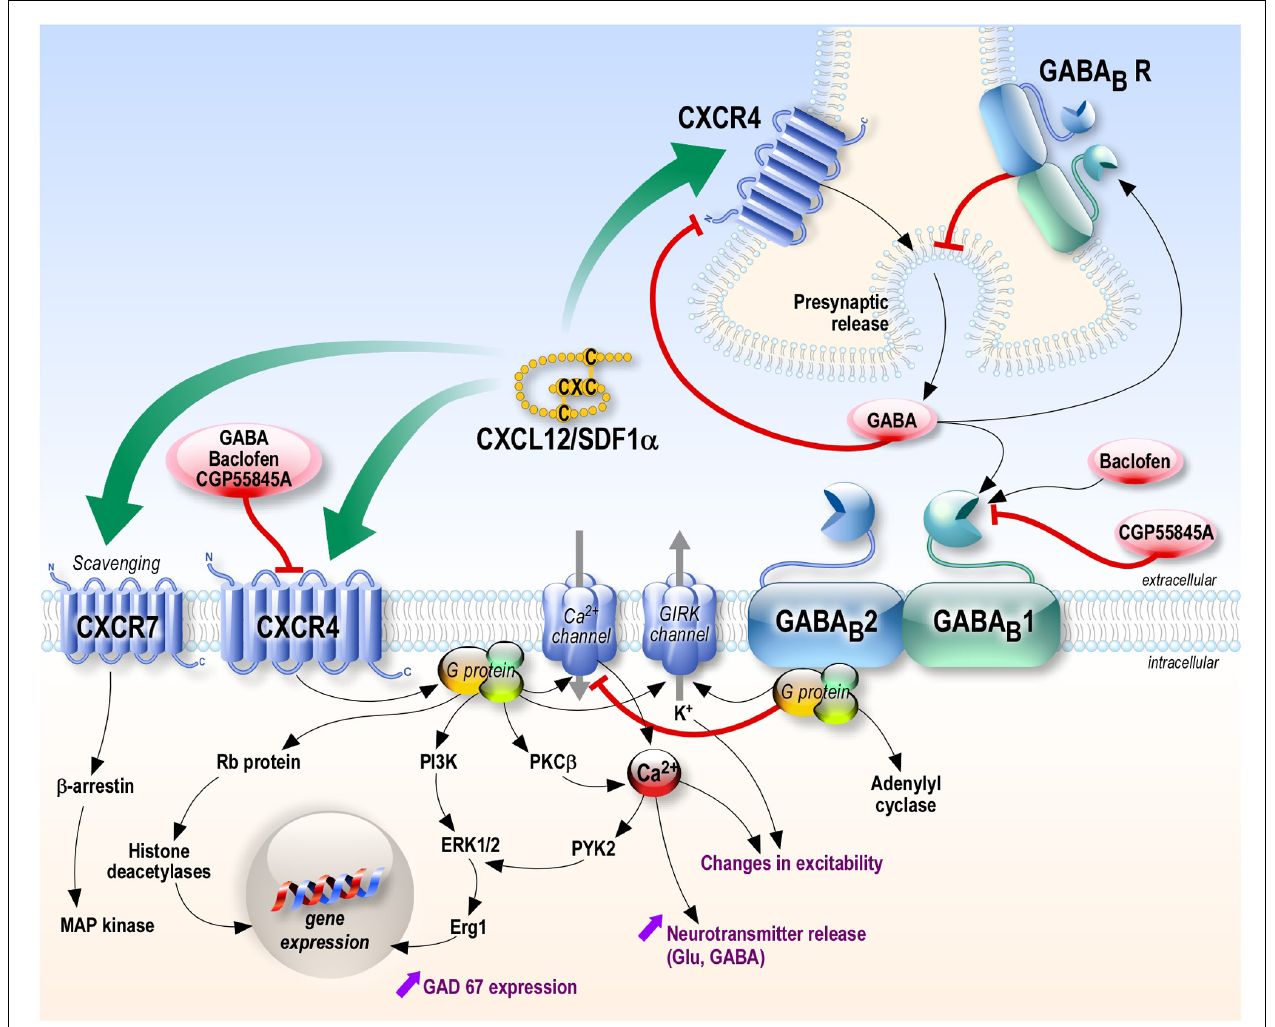
FIGURE 1 | Putative crosstalk between CXCL12-CXCR4/CXCR7 and GABAergic systems. The chemokine CXCL12 can act on its receptors CXCR4 and CXCR7, activating several intracellular pathways. At the pre-synaptic level, CXCR4 stimulation increases the pre-synaptic release of neurotransmitter such as GABA (opposite to GABA B receptors stimulation). CXCL12 receptors and GABA B receptors could interact at different levels including the receptors